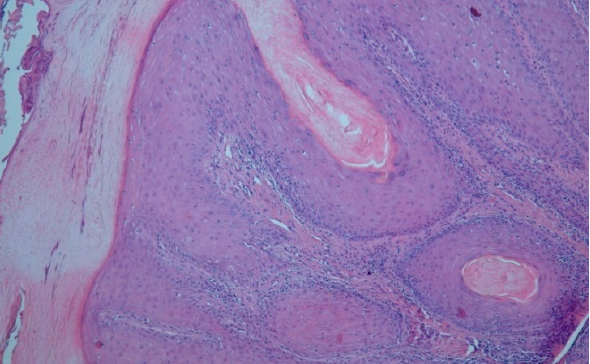
Figure 5. Histological imaging of the Ackermann carcinoma in Case 2. By courtesy and permission of Prof. Dr. P. von den Driesch, Department of Dermatology, Stuttgart General Hospital